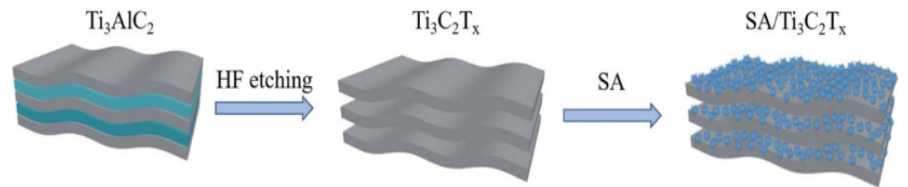
Figure 5. Schematics for the synthesis of MXene/alginate composites [66].